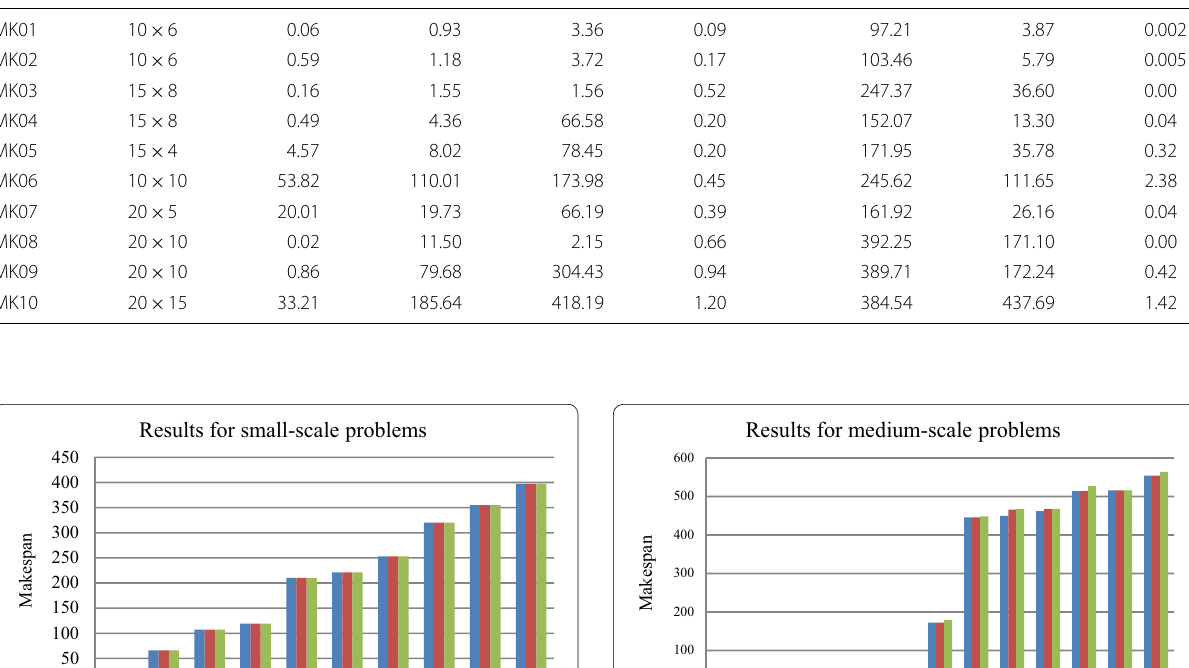
Table 6 CPU time comparison for instances in experiment 3 Ins.